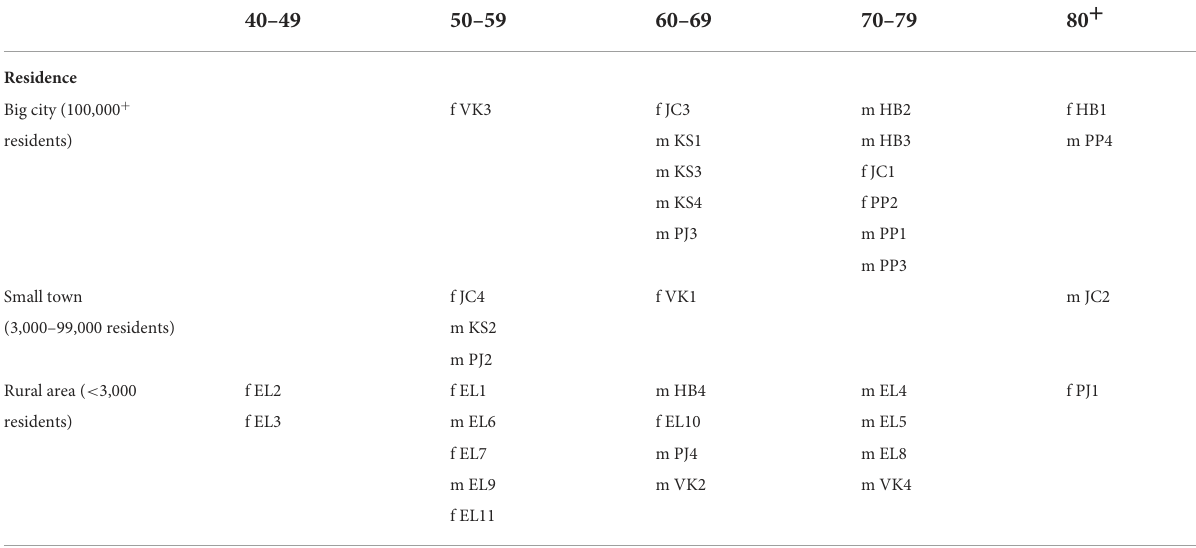
TABLE 1 Selection